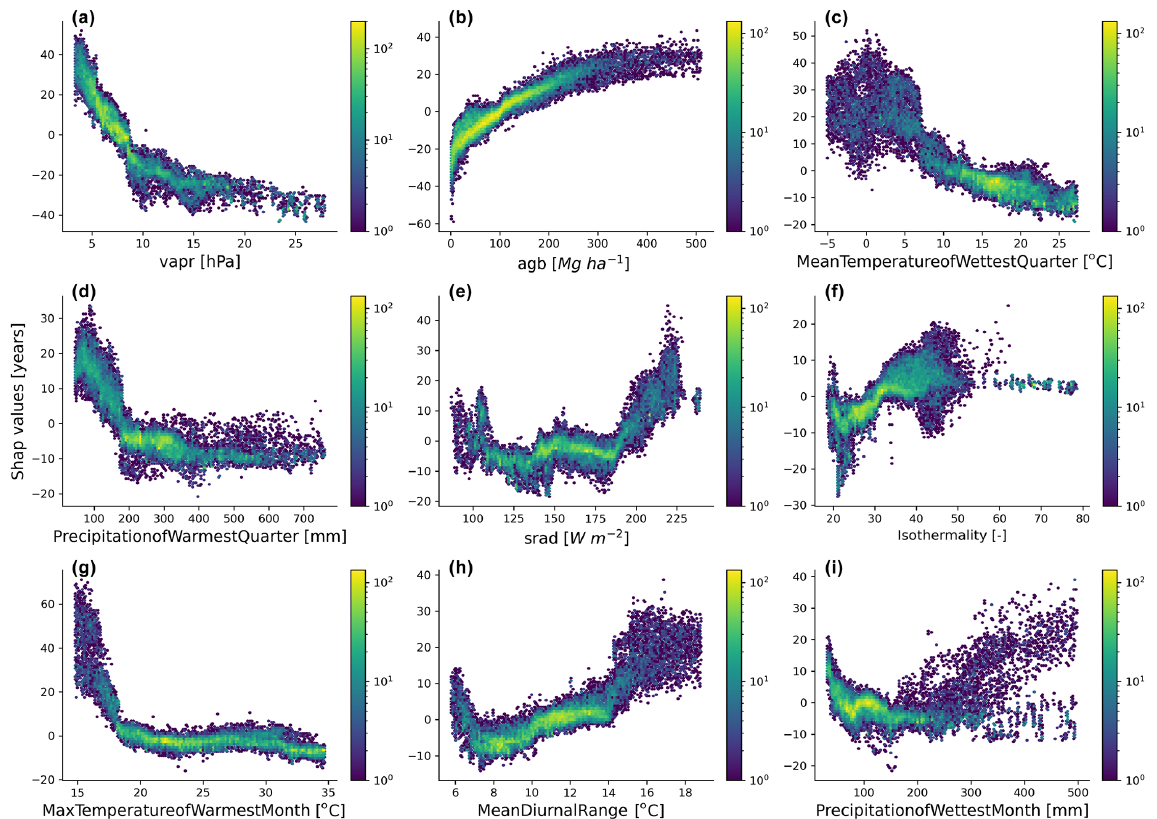
Figure 5. Emergent relationships between the retrieved SHAP values and the independent variables selected by the feature selection algo- rithm.